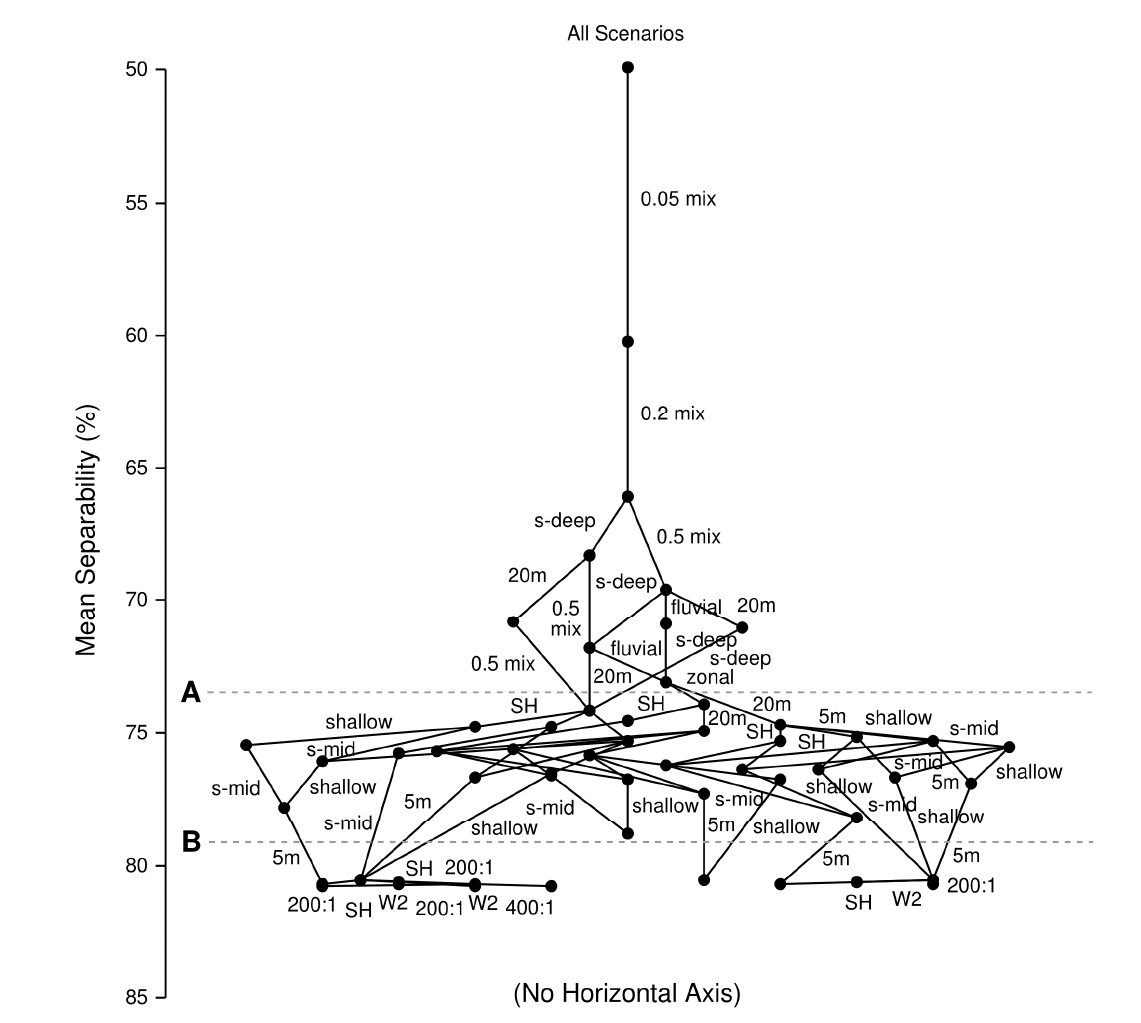
Figure 11. Hierarchical factor diagrams for separability of Bleached Coral from Live Coral. The diagram should be read vertically only, starting at the vertex labelled “All Scenarios”. Subsequent arcs indicate the exclusion of classes as labelled (Table 2) with the vertical position of vertices showing mean separability over the remaining subset of scenarios. Vertices are spaced horizontally for clarity and horizontal position has no meaning. Lines A and B indicate narrow points in the graph network which partitions the results into regions. These regions represent groups of classes that have a similar effect on overall separability, with the most significant groups at the top of the figure. The region above line A separates sub-pixel mixtures and deep waters as the most important factors. Line B separates mid-depth waters from sensor noise, wind speed and sun